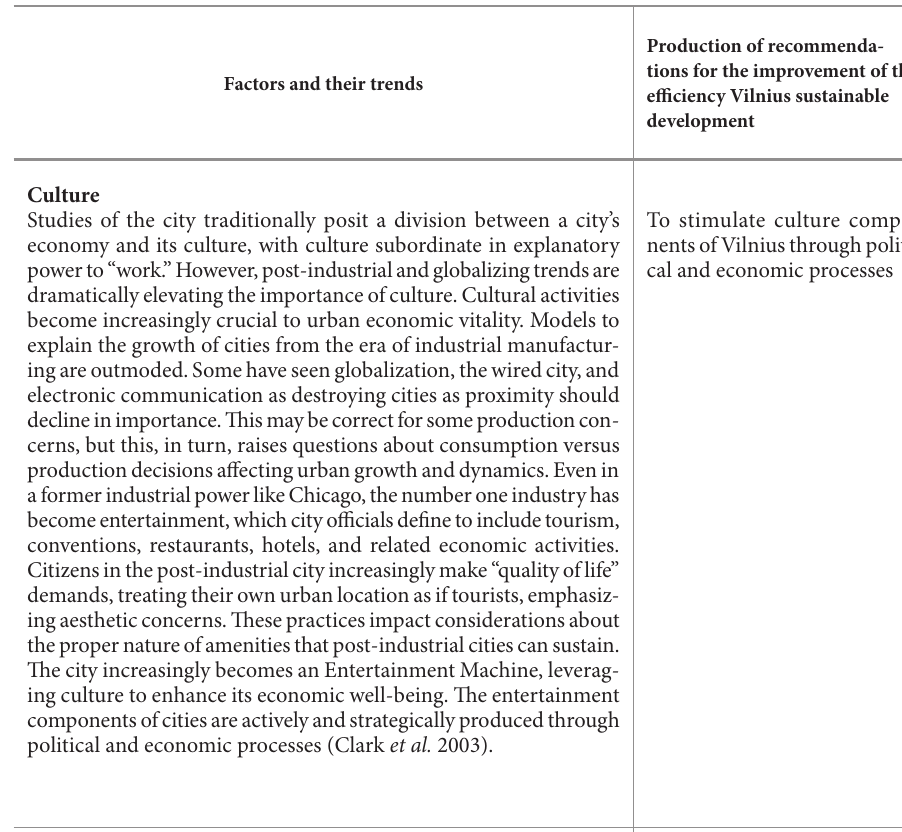
Table 1. Identification of global development trends (general regularities) of the sustainable urban development and the presentation of some general recommendations as how to improve the efficiency levels for sustainable